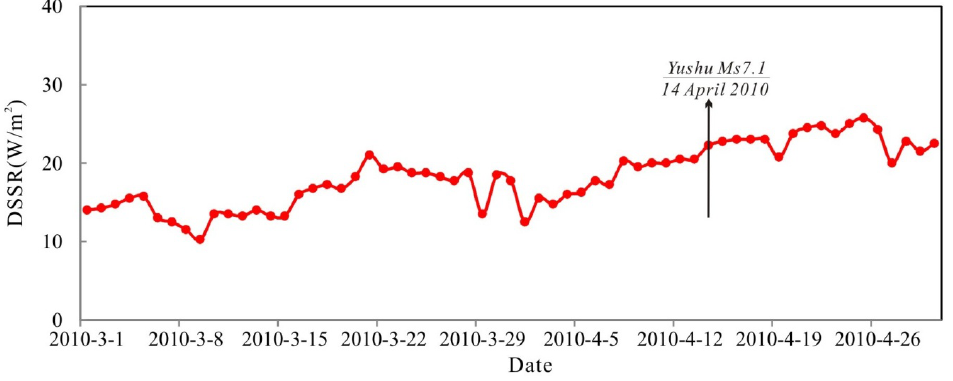
Figure 4. Time series of FY-VISSR DSSR, in the epicenter pixel group (33°N–34°N, 96°E–97°E) of the Yushu earthquake.